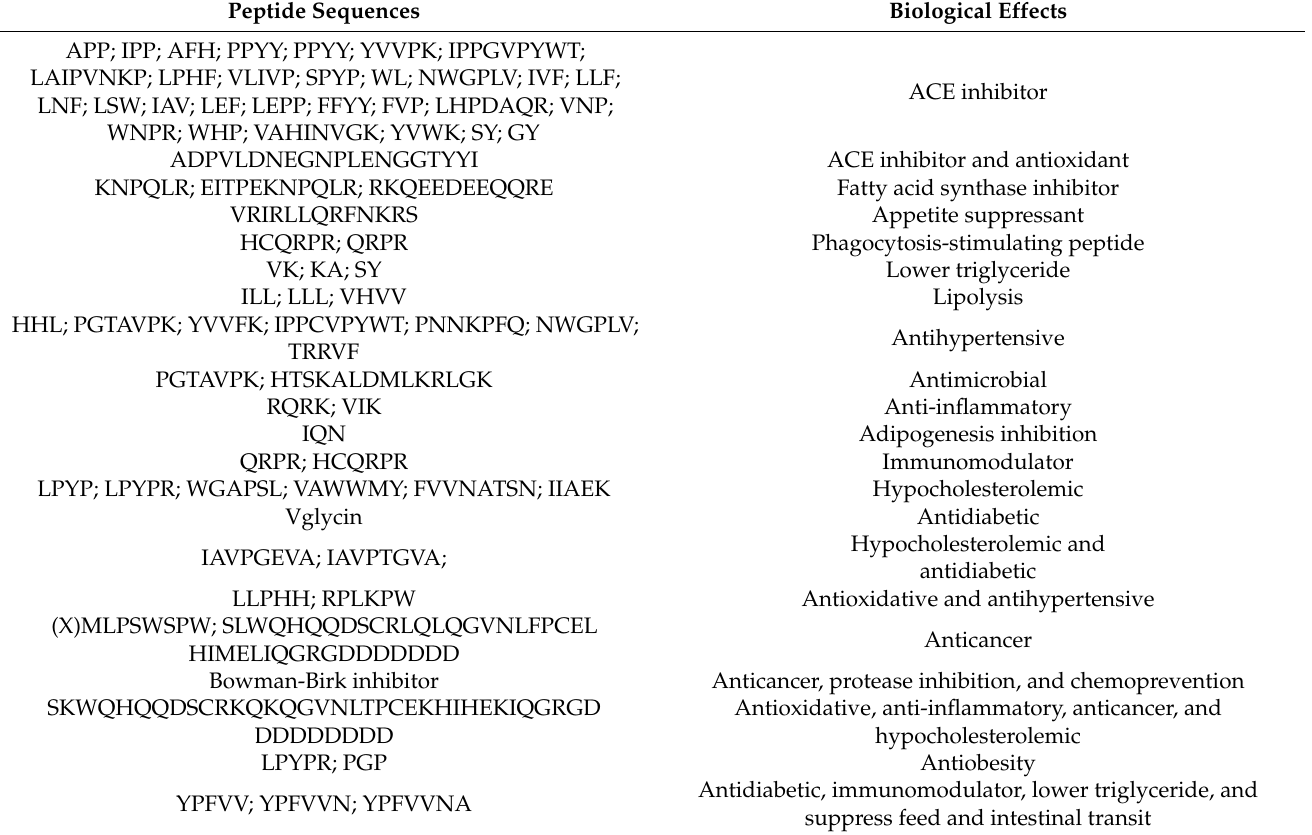
Table 2. Potential bioactive peptides derived from soybean and its by-products [5,134]. Peptide Sequences Biological